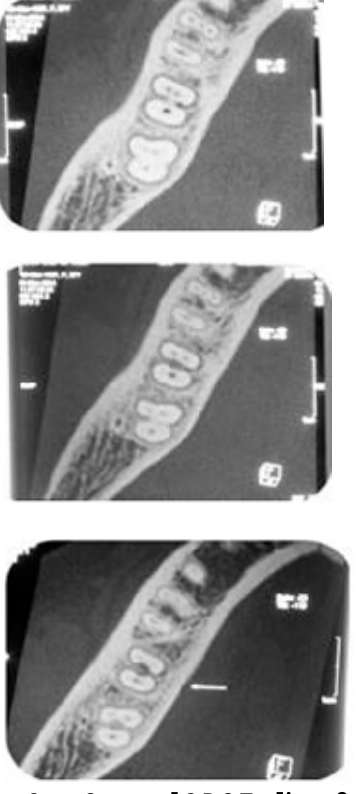
Figure 2: a. Coronal CBCT slice of right mandibular first molar at various levels